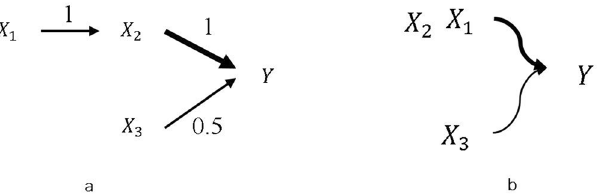
Figure 1. Data generating diagram and univariate contribution of X 1 , X 2 , X 3 to Y . ( a ) The causal diagram of our data-generating model. ( b ) The univariate contribution of each variable. The overlapped area represents shared explained variance of each variable in univariate